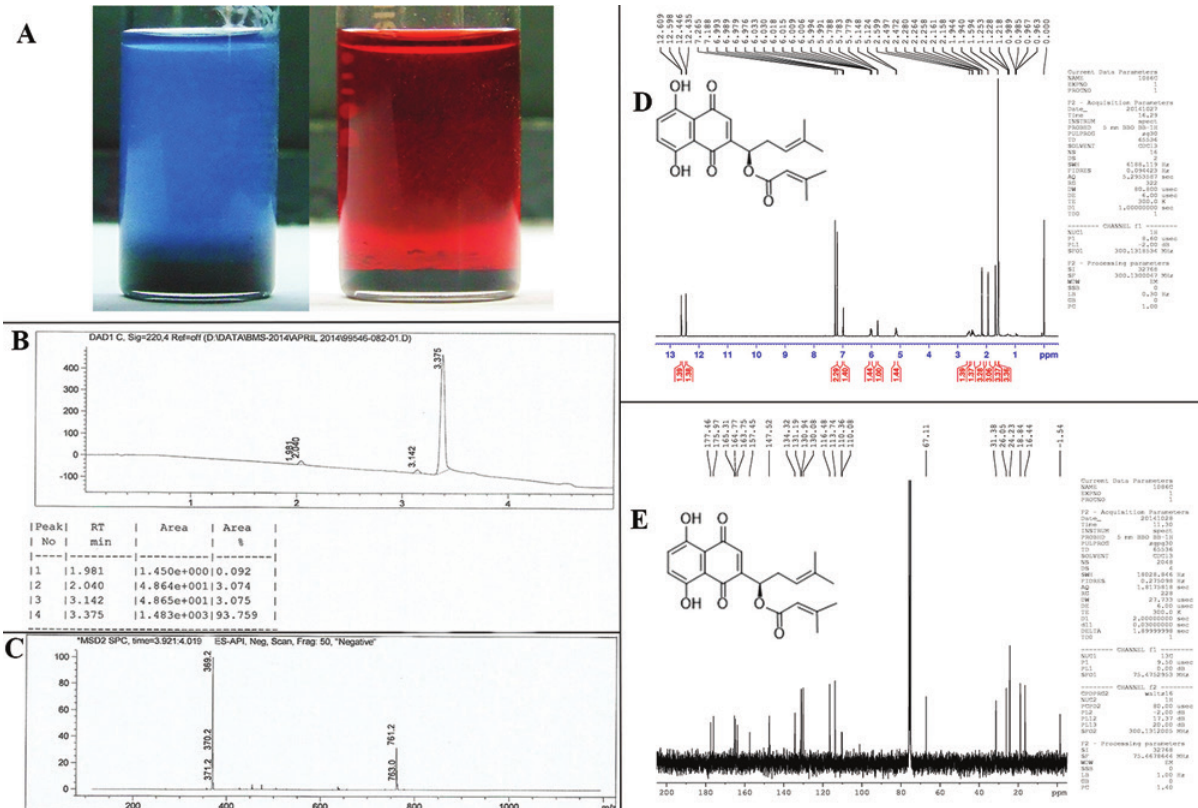
Figure 2: (A) Alkaline sucrose extract of A. nobilis (left), precipitate obtained after neutralization at pH 7 [ β , β -dimethylacryl shikonin (BDMS) = 93.75% pure) (right); (B) HPLC-DAD profiles of pure BDMS isolated using alkaline sucrose extraction process from A. nobilis ;